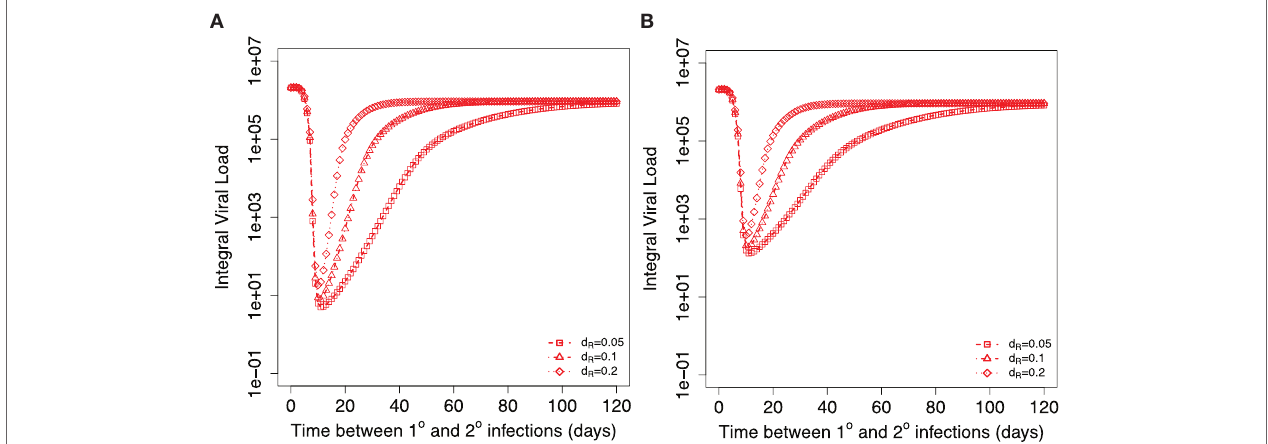
FIGURE 4 | Dependance of integral viral load achieved during secondary influenza infection on the time between primary and recall infections . Different symbols show three different indicated values for the model parameter d R describing the decay of resident T cells at the site of infection. (A) shows the case when resident memory T cells are able to kill the virus infected cells immediately after the onset of secondary infection. (B) considers the case when resident T cells require activation to be able to kill virus-infected cells. Corresponding parameters are k act = 0.2 TCID 50–1 mlday –1 , k RM = 0.2, ϕ R = 1.